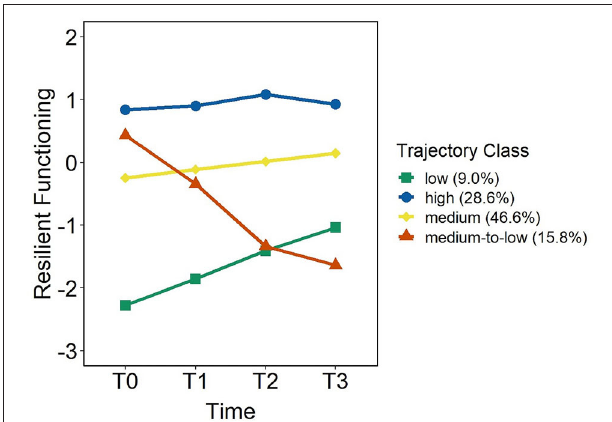
FIGURE 2 | Trajectories of resilient functioning from T0-T3 according to the four-class